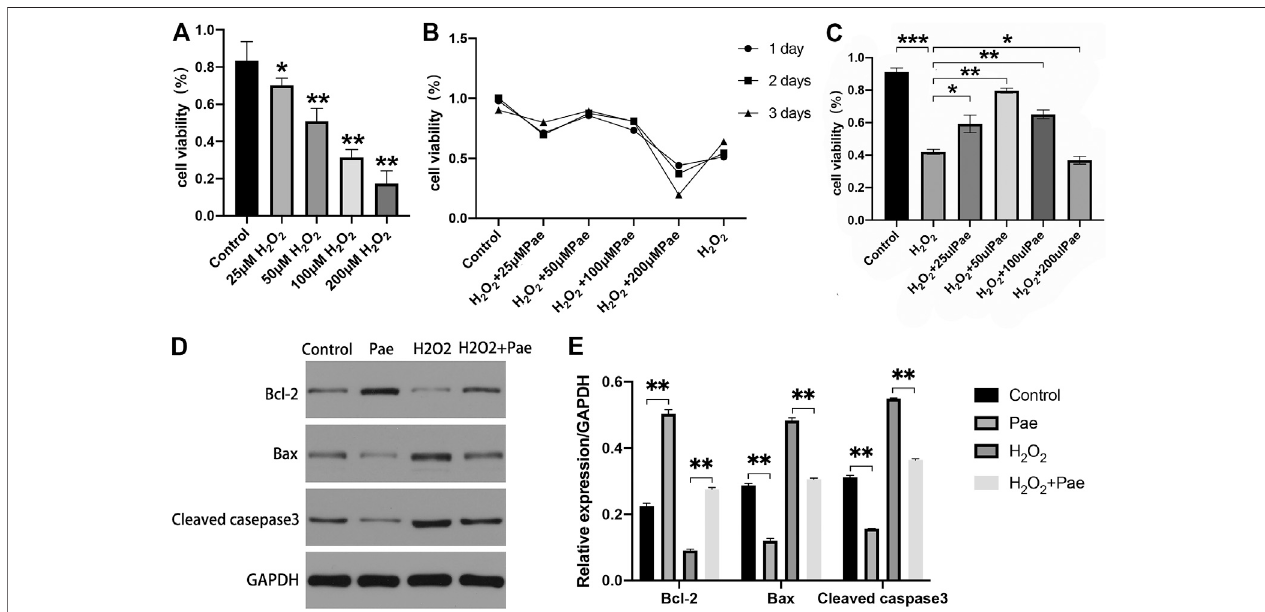
FIGURE 5 | Effects of Pae on H 2 O 2 -induced decrease of viability and enhancement of apoptosis in 661W cells. (A) Cells were stimulated with 0, 25, 50, 100 or 200 μ MH 2 O 2 ,andcellviabilitywasmeasuredbyCCK-8assay.Non-treatedcellswereactedascontrol. (B) Cellswerestimulatedby100 μ MH 2 O 2 with0,25,50,100or 200 μ MPaeandControlgroupfor1,2or3days,andcellviabilitywasmeasuredbyCCK-8assay. (C) Cellswithouttreatmentandweretreatedwith100 μ MH 2 O 2 alone or with the presence of 25, 50, 100 or 200 μ M Pae, and cell viability was measured by CCK- 8 assay. (D, E) Western blot analysis was performed to assess the expression of apoptosis-related proteins. Data presented are the mean ± SD ( n (cid:1) 3). * p < 0.05, ** p < 0.01, *** p <